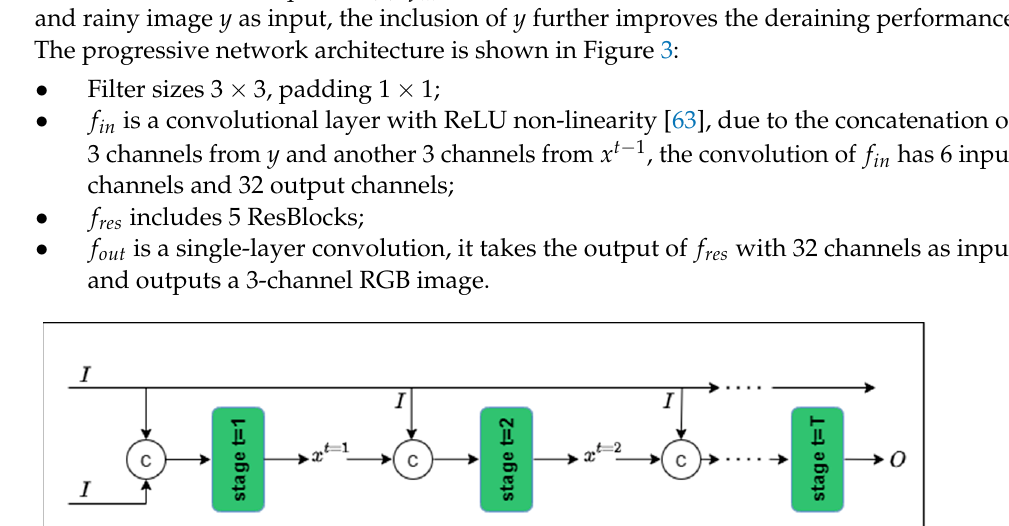
Figure 2. A basic ResNet.